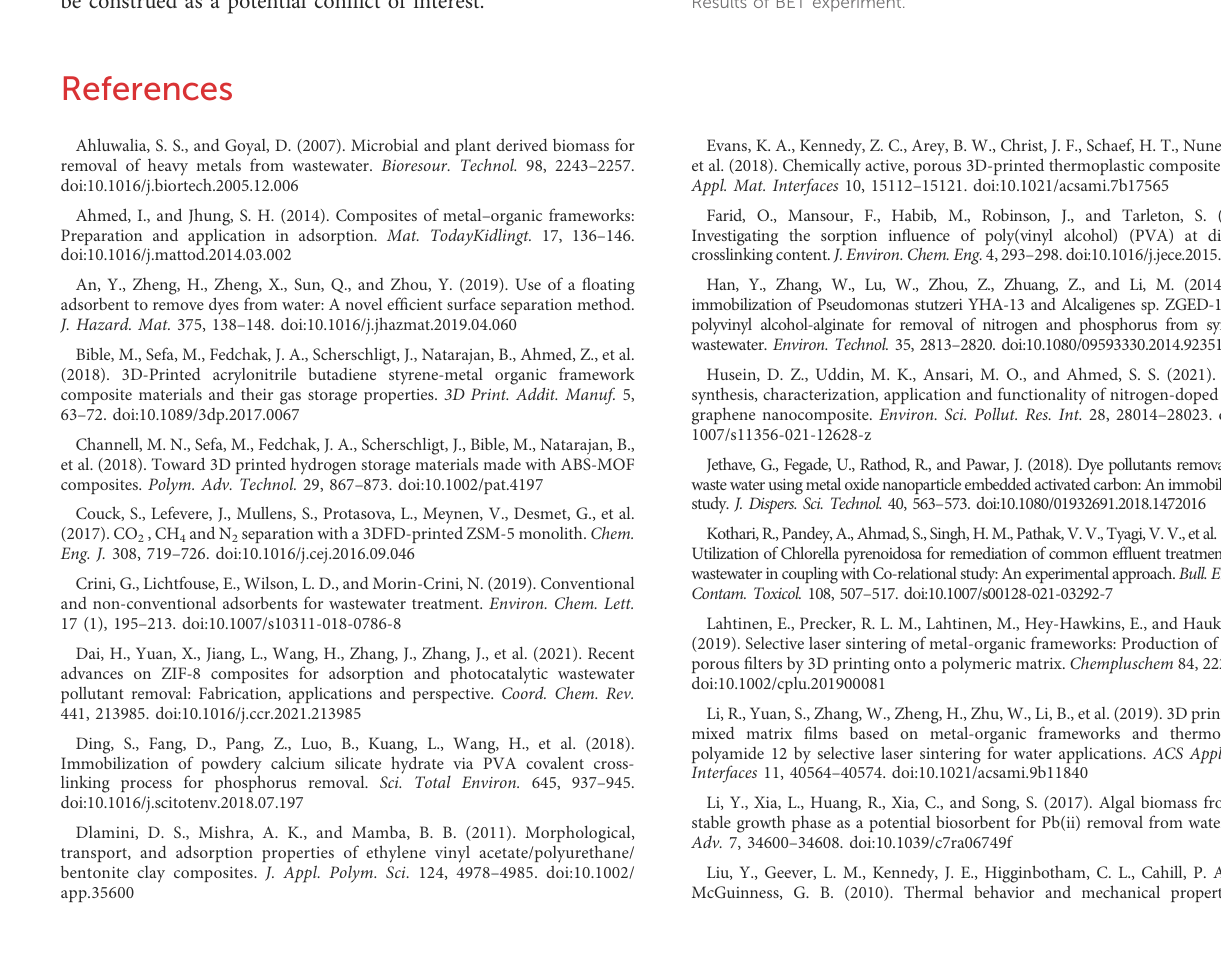
SUPPLEMENTARY FIGURE S1 (A,B) SEM images of capsule before cross-linked, (C,D) SEM images of capsule after cross-linked. SUPPLEMENTARY FIGURE S2 (A,B) SEM images of CP powder before adsorption of lead ions, (C,D) SEM images of CP powder after adsorption of lead ions. SUPPLEMENTARY TABLE S1 Results of BET